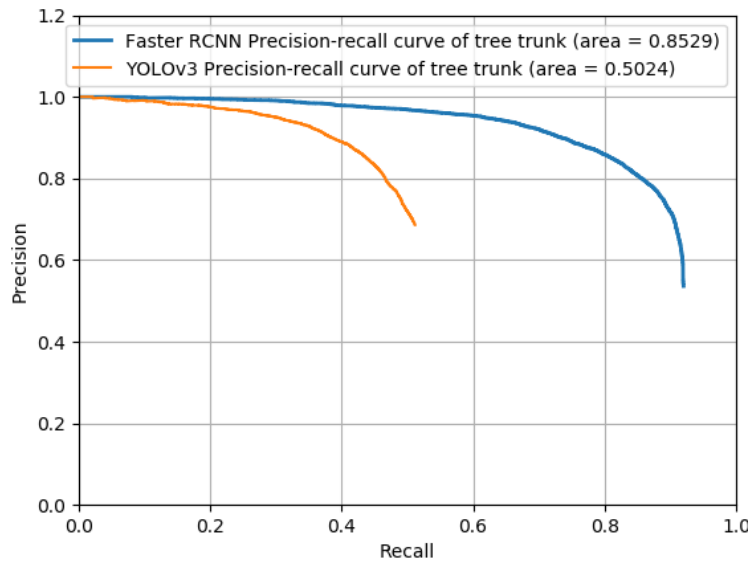
Figure 11. Precision-recall curve of Faster R-CNN and YOLOv3 validation.